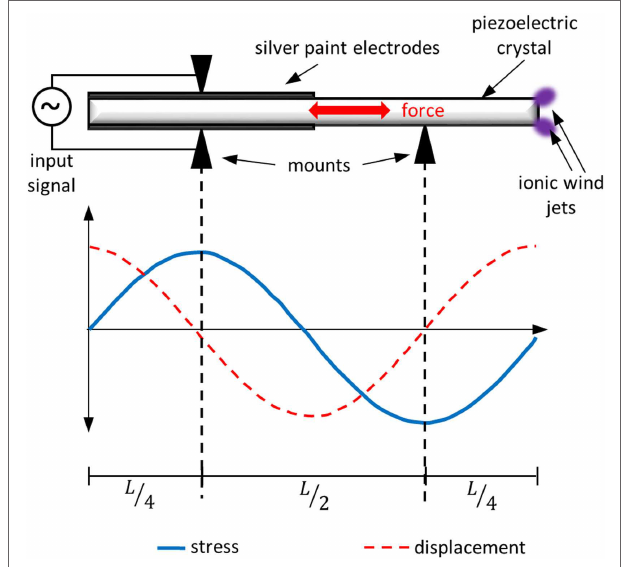
FIGURE 1 | A schematic of the piezoelectric transformer . The plot at the bottom shows the stress and the displacement within the piezoelectric when operated at its second resonant frequency. The mounts from the transformer were designed so that they only make contact with the piezoelectric where there was no displacement (nodes of the displacement wave). For the second resonant frequency, these nodes are located L /4 from the ends of the